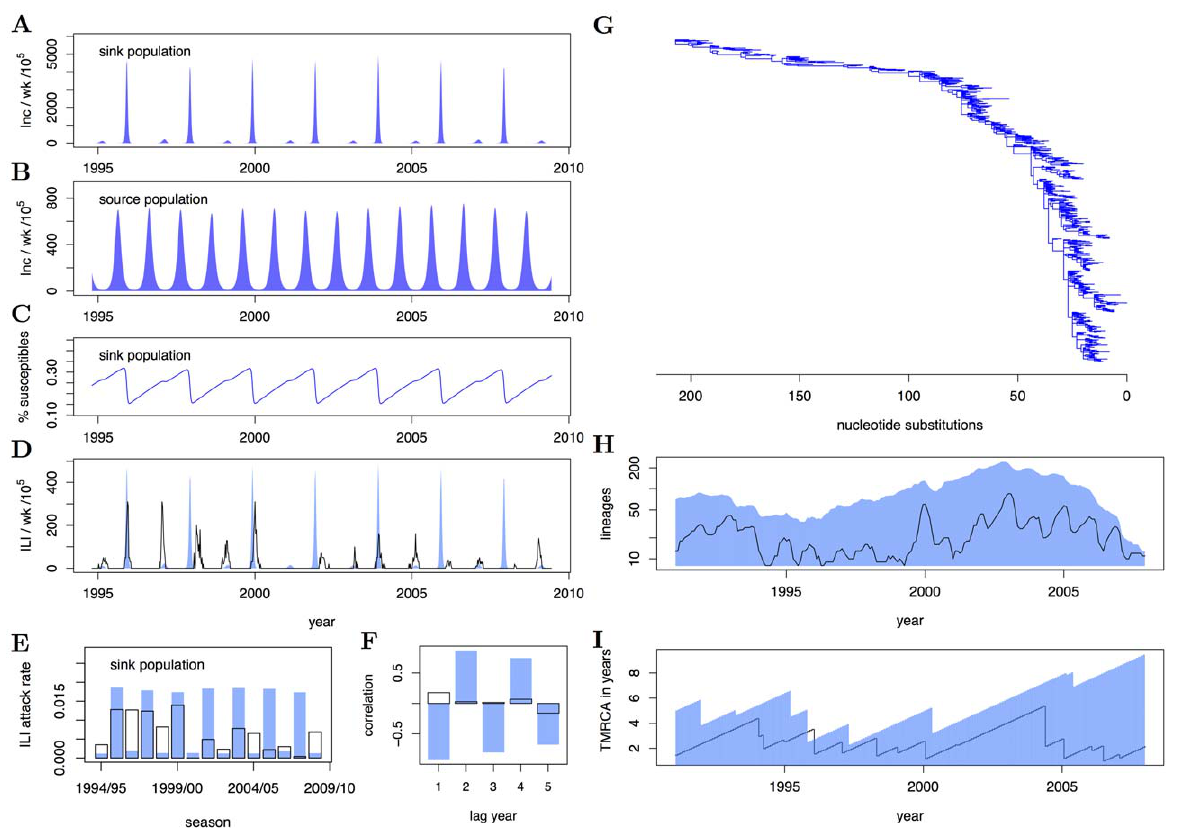
Figure 4. Phylodynamics arising under the spatial SEIRS model. (A–B) Population-level weakly incidence in the sink and source population, respectively. (C) Corresponding weekly time series of the percentage of susceptible individuals in the sink population. (D) Simulated H3N2 weekly surveillance time series in the sink population (blue) and reconstructed H3N2 time series in the Netherlands (black). (E) Simulated and observed case report seasonal attack rates, and (F) autocorrelation function of case report peaks. Typically, simulations under the fitted model show sustained oscillations that follow a clear biennial pattern. (G) Simulated HA phylogeny under a large, estimated residual selection parameter. (H) Simulated and observed lineage profile, and (I) simulated and observed time series of the time to the most recent common ancestor of extant phylogenetic lineages. Despite a relatively high selection parameter, the number of lineages and the time to the most recent common ancestor are overall too high when compared to data. Model parameters are R 0 ~ 3 , 1 = w ~ 0 : 9 , 1 = n ~ 1 : 8 , 1 = c ~ 8 : 5 , r ~ 0 : 11 , N s ~ 1 : 2 | 10 8 , 1 = m s ~ 50 , Q ; ~ 0 : 4 , Q s ~ 0 : 01 , m ; ~ 7 : 7 | 10 6 , m s ~ 0 : 04 , f ~ 1 : 2 , s ~ 0 : 04 .